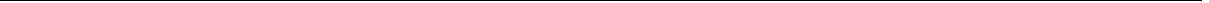
Fig. 2 Ccr5 heterozygous null mutation ( Ccr5 + / − ) augments pre-training and learning-related spine dynamics in RSC. a Timeline of CFC training and imaging. b Ccr5 + / − mice have increased baseline spine turnover prior to CFC (Day − 3 to Day 0) relative to WT littermates ( Ccr5 + / − n = 10 (12.5%), WT n = 9 (7.6%); U = 6.00, p = 0.0006). c Ccr5 + / − mice show enhanced contextual learning and memory relative to WT littermates ( Ccr5 + / − n = 12, WT n = 15; Two-way RM ANOVA, genotype×time interaction: F (4,100) = 2.60, p = 0.0404; Bonferroni post-test for Day2: p < 0.05). d The percentage of new spines added in clusters during CFC is signi fi cantly greater for Ccr5 + / − vs WT ( Ccr5 + / − n = 10 (62.6%), WT n = 9 (42.1%); U = 15.50, p = 0.0178). e Clustered spines added during CFC are more stable at 4 weeks post-training than non-clustered spines (61.6% vs 36.4%, n = 18 mice with combined Ccr5 + / − and WT; U = 62.50, p = 0.0017). f Timeline of MWM training and imaging. g Ccr5 + / − mice have increased baseline spine turnover prior to MWM (Day − 4